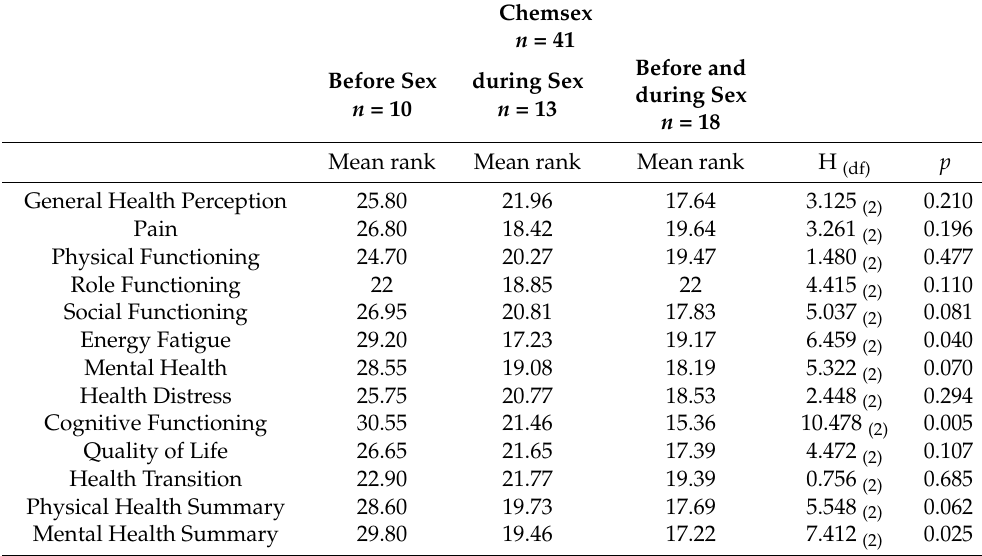
Table 8. Differences in HRQoL between participants who took drugs before sex, during sex or before and during